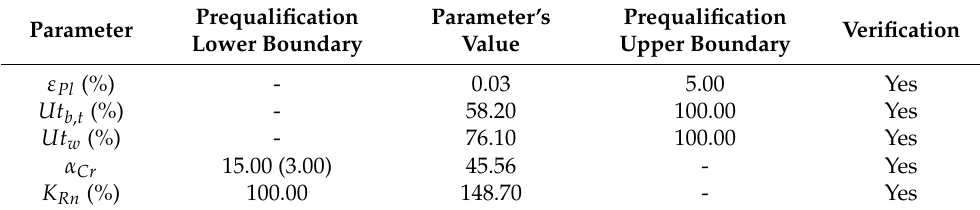
Table 7. Essential results of the EPC 8E NP model.